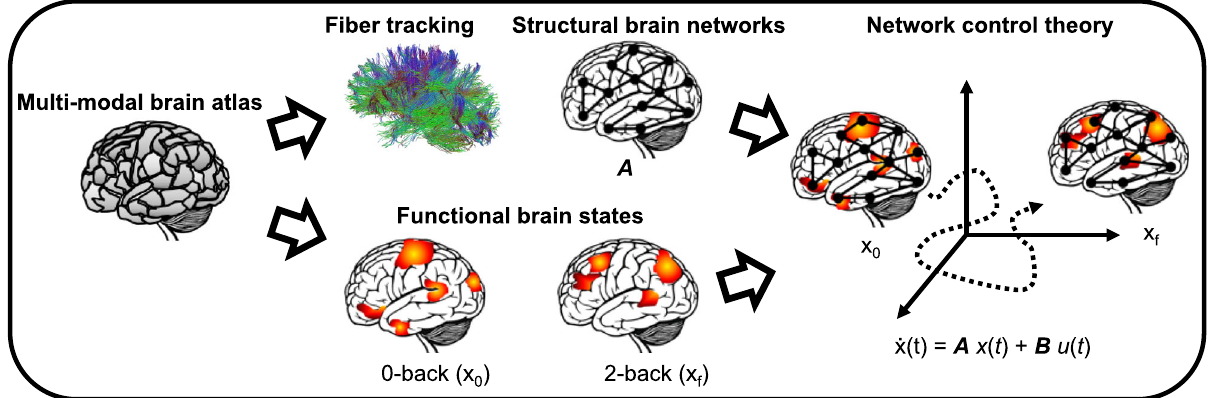
Fig. 1 Theory and methods. A summary of the methods to assess brain dynamics using network control theory. We use a multimodal atlas and apply it to both diffusion tensor imaging to obtain a structural connectome, and to functional magnetic resonance imaging to obtain activation patterns during 0-back and 2-back working memory tasks. Finally, we use network control theory to explain transitions between 0-back and 2-back states based on the underlying structural connectome. Here, x 0 denotes the initial state of the system, x f denotes the desired fi nal state, x ( t ) is the state of the system at time t , A is the wiring diagram of the underlying network, B denotes an input matrix de fi ning the control nodes, and u ( t ) is the time-dependent control signal. For further mathematical details, please see the “ Methods ”